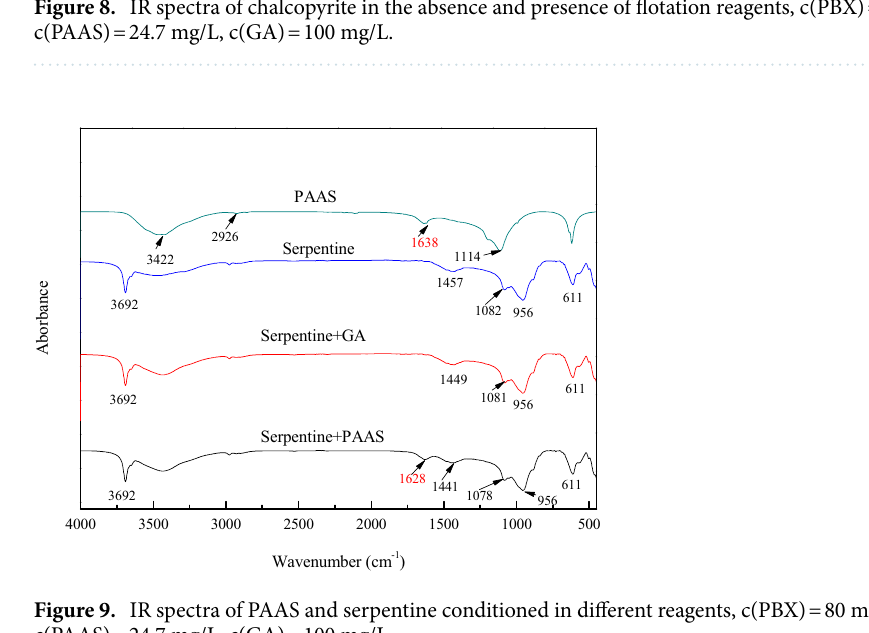
Figure 9. IR spectra of PAAS and serpentine conditioned in different reagents, c(PBX) = 80 mg/L, c(PAAS) = 24.7 mg/L, c(GA) = 100 mg/L.